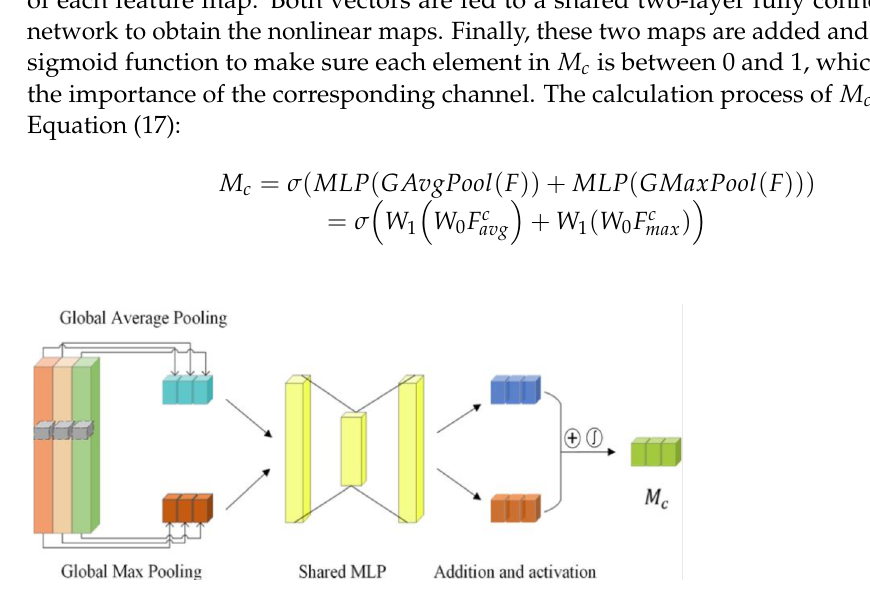
Figure 6. The computation operation of the channel attention